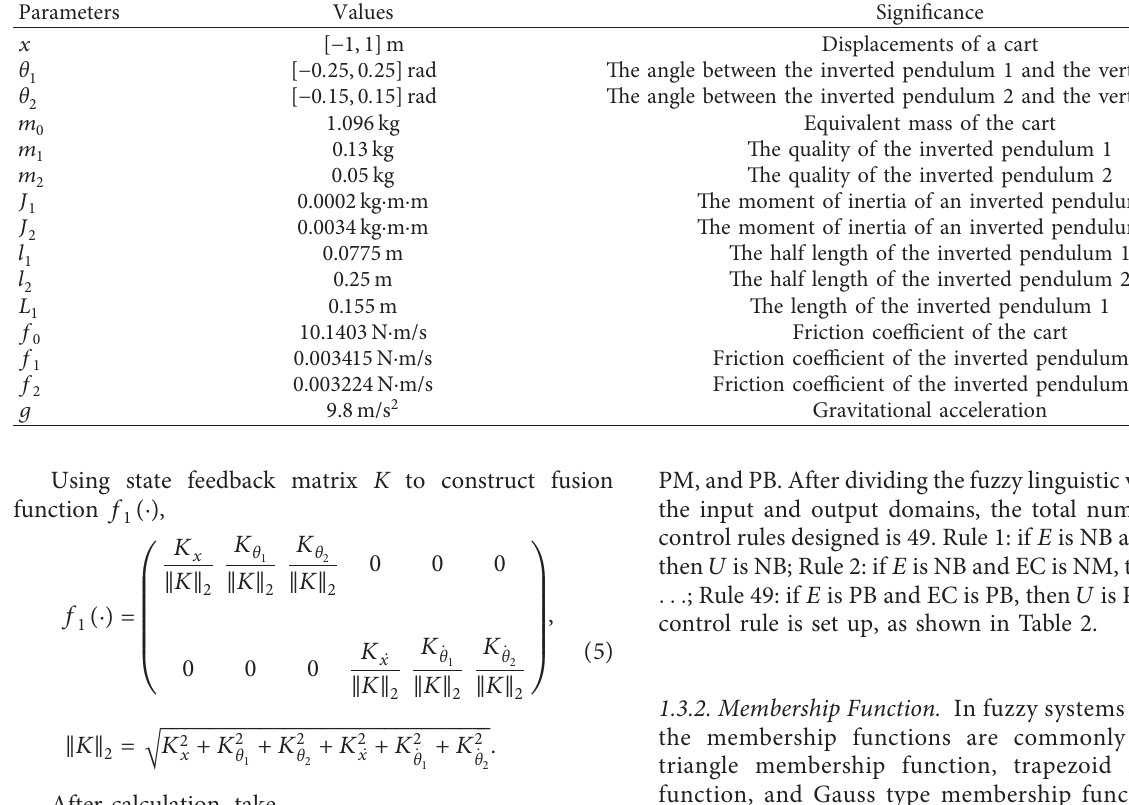
Table 1: Introduction of symbols used in the double inverted pendulum system [17].